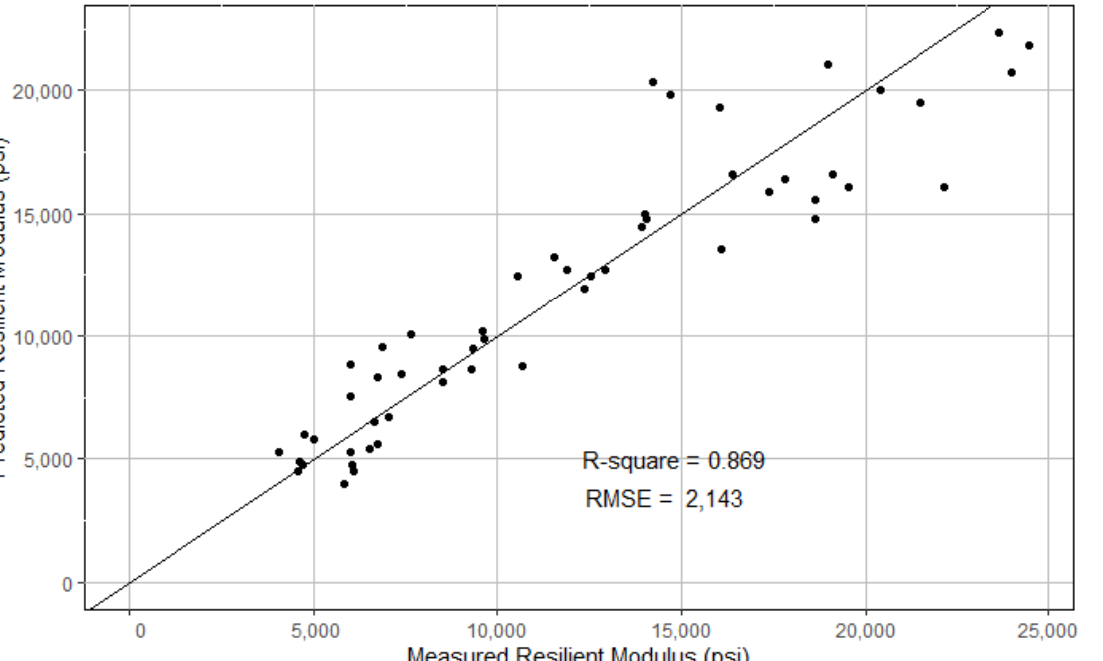
Table 5. Comparison of model performance on the test dataset.